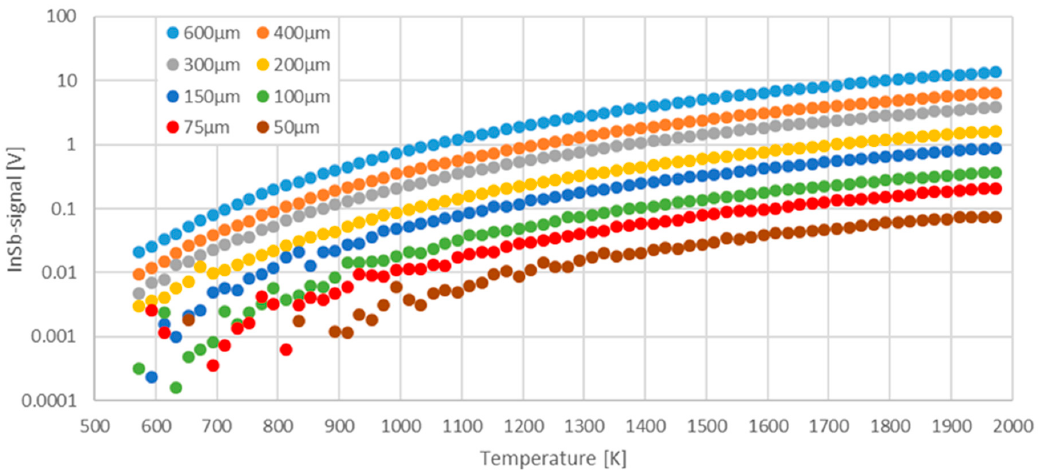
Figure 3. This figure shows the measured blackbody reference data.